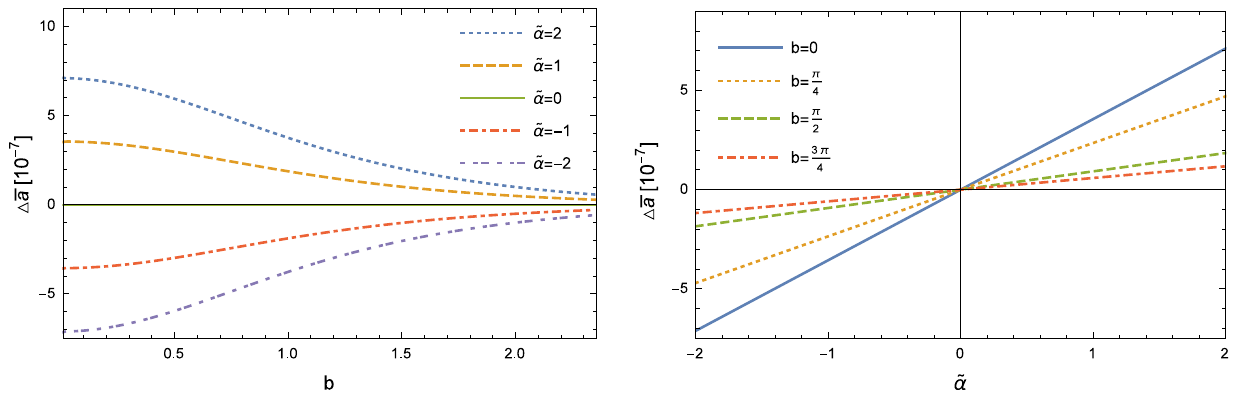
Fig. 2 Variation of the difference of minimum impact parameter (cid:15) u ps with phantom hair b (left) and coupling constant (cid:12) α (right) in the regular phantom black hole